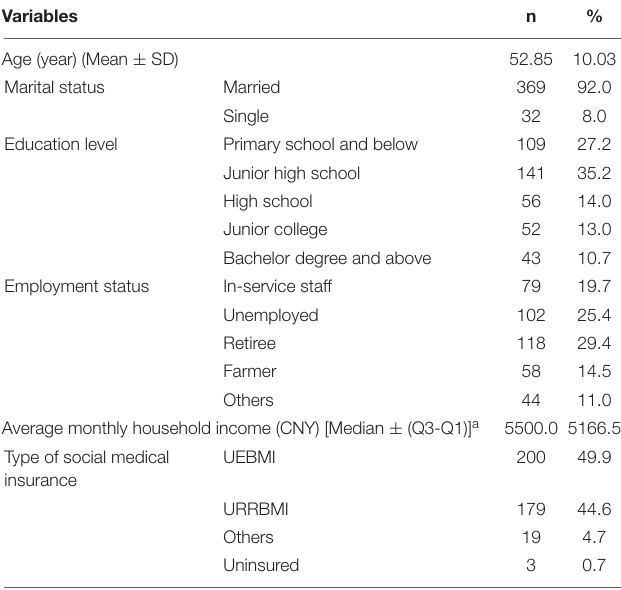
TABLE 1 | Sociodemographic characteristics ( n =